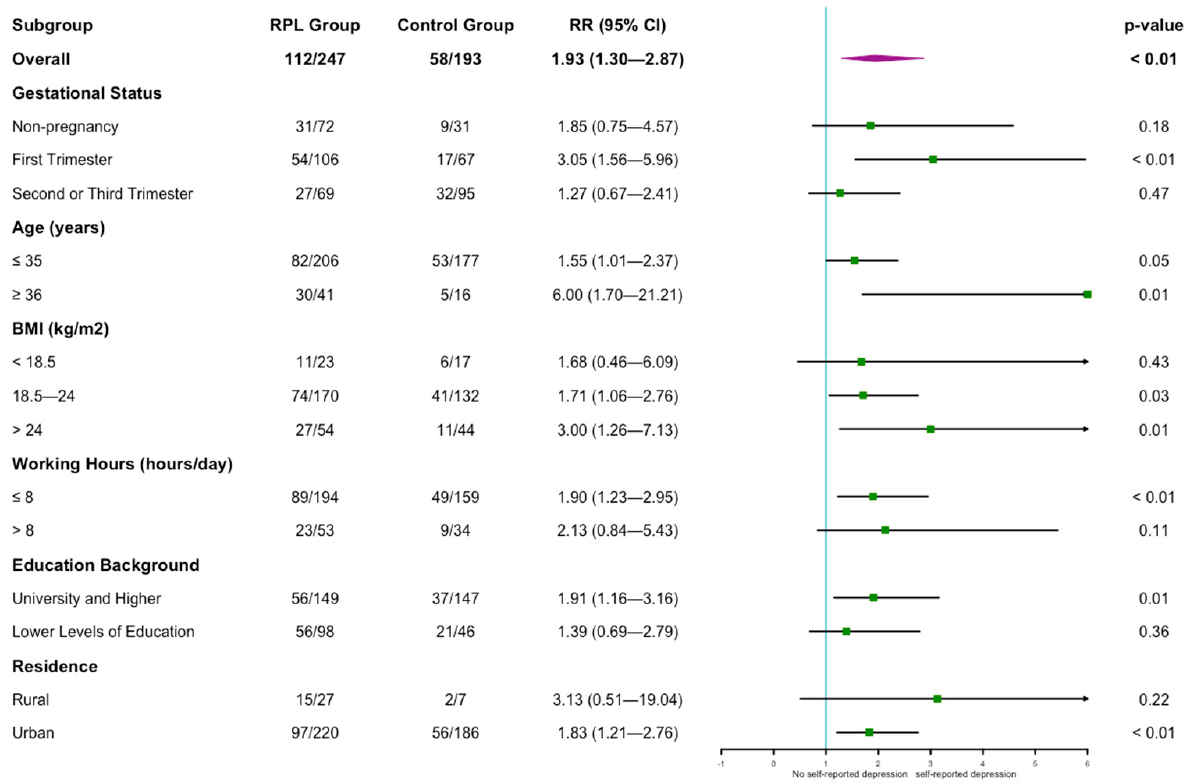
Figure 1. Forest plot of subgroup analyses of self-reported depression between the two groups. RR: relative risk; CI: confidential intervals. p -values were calculated by univariable regression analysis, and p < 0.05 was regarded as a statistical difference.